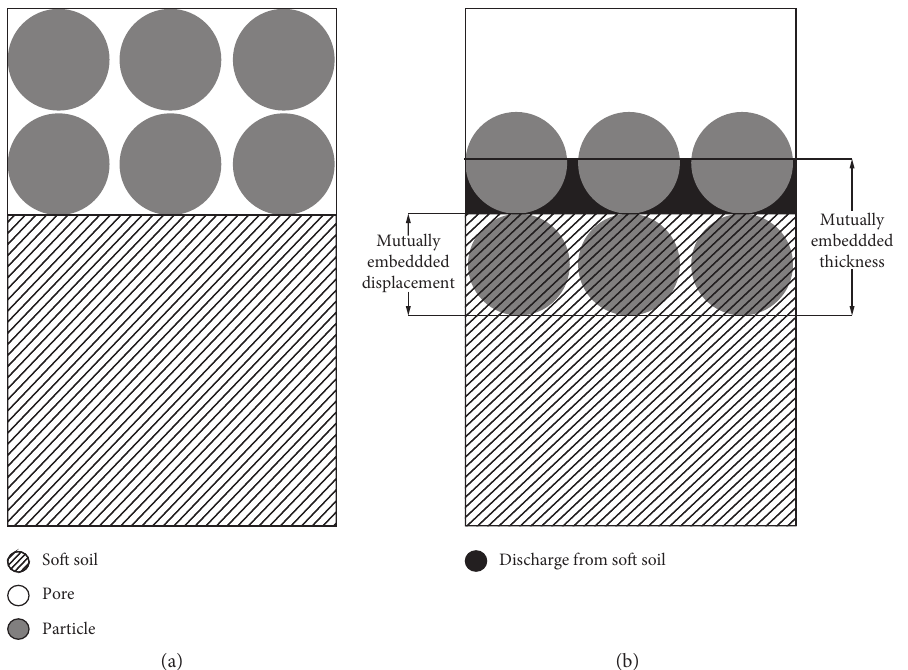
Figure 1: An example of mutual embedding of soft soil and miscellaneous fill particles: (a) before mutual embedding; (b) after mutual